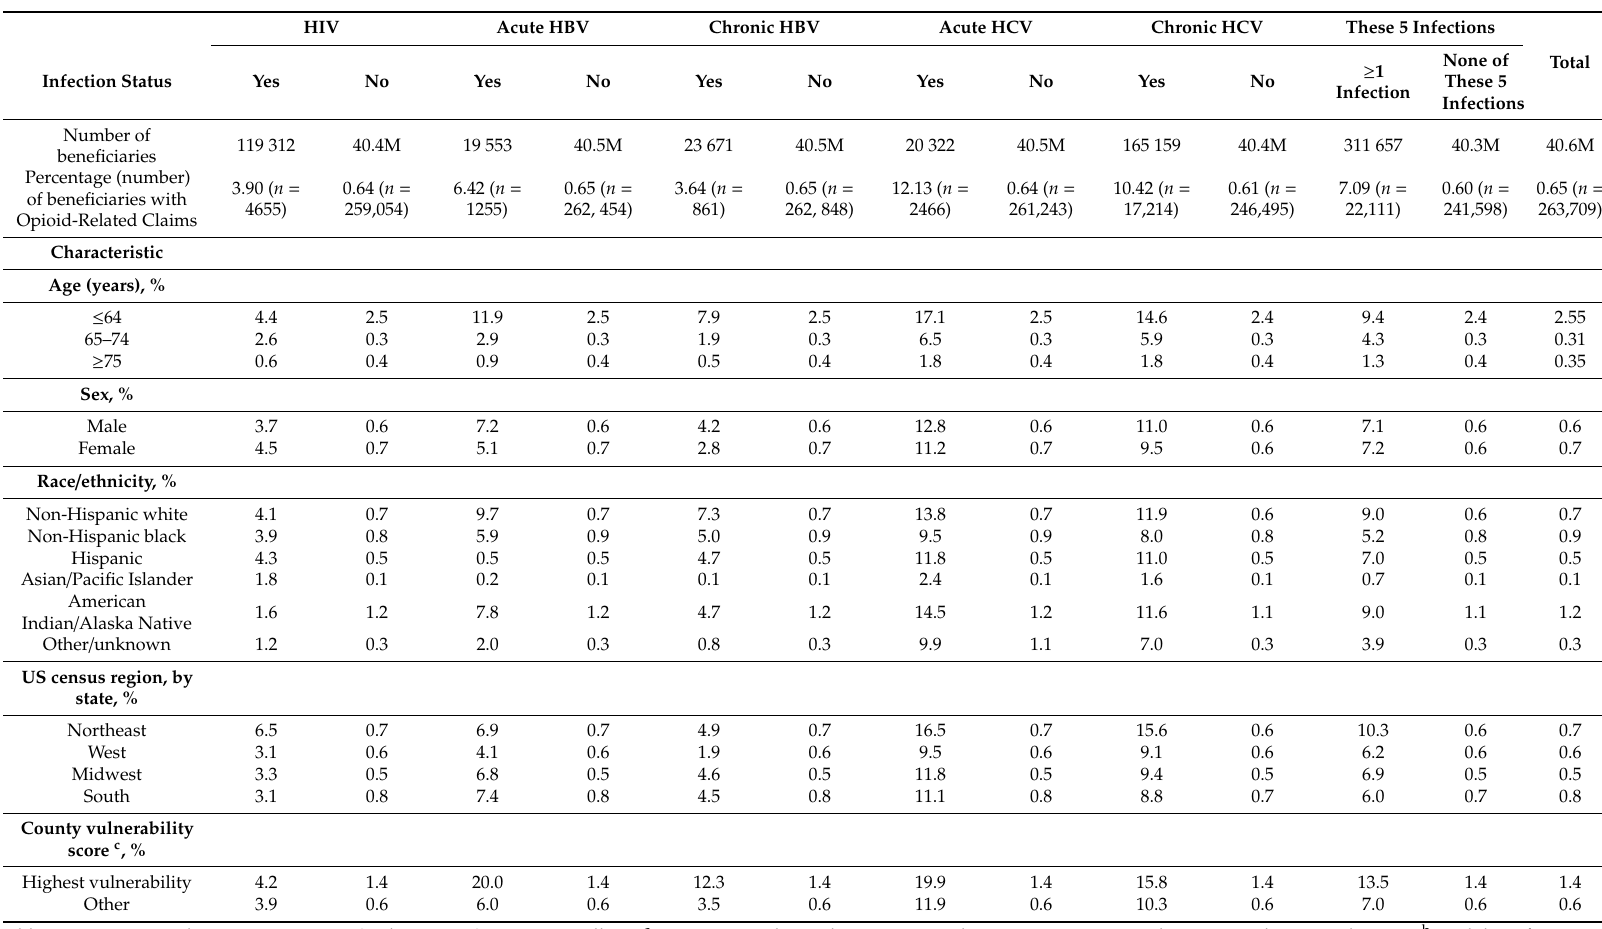
Table 2. Number and percentage of beneficiaries with opioid-related claims, a by demographic characteristics among the Medicare fee-for-service beneficiaries who had or did not have HIV, HBV, or HCV claims, a,b United States,